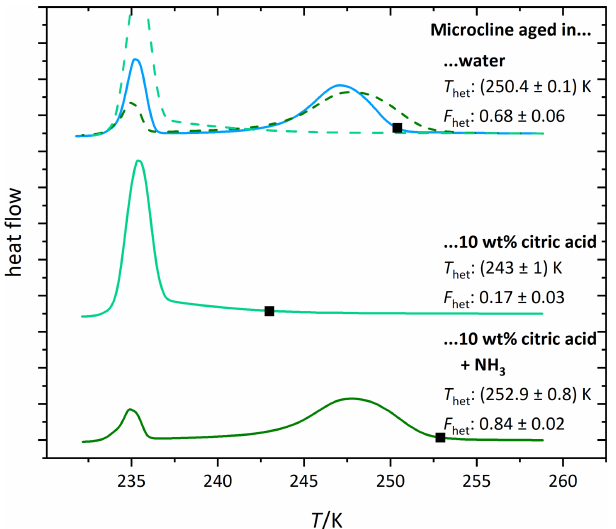
Figure 6. DSC thermograms of microcline (2wt%) after 10d of aging in the respective solutions (citric acid: 10wt%, a w ≈ 0 . 984; neutralized citric acid: 10wt%, a w ≈ 0 . 975) and subsequent wash- ing. The thermograms are normalized with respect to their total in- tegral. The average freezing onset temperatures are marked by black squares. For easier comparison the thermograms of the solutions are overlaid as dashed lines above the first thermogram. The displayed T het and F het values are the average of two measurements. The cor- responding uncertainties are the standard